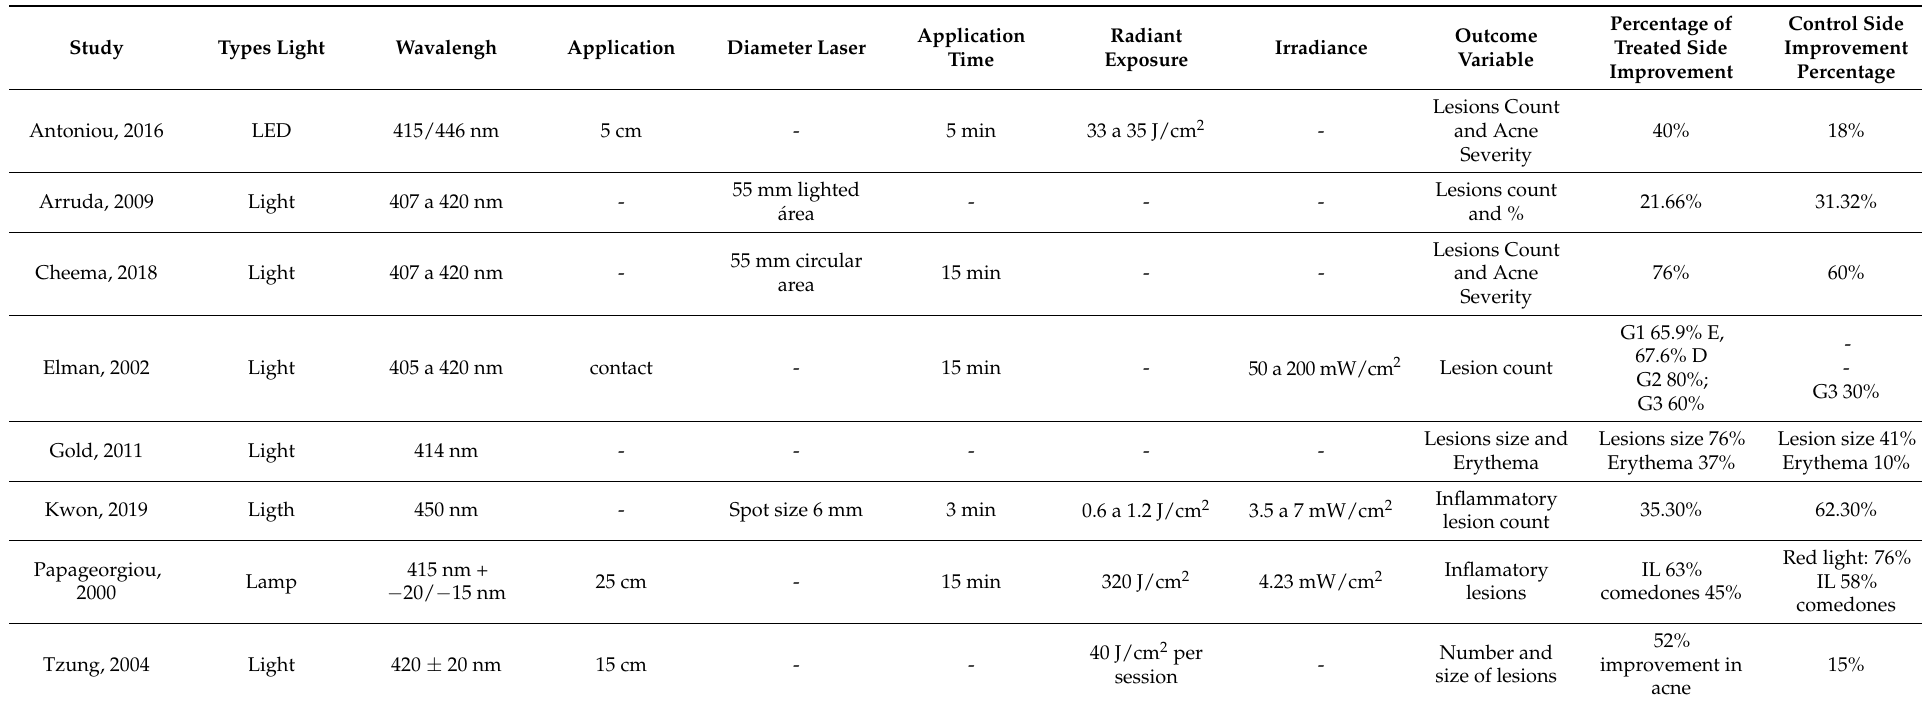
Table 3. Detailing the protocols presented in clinical